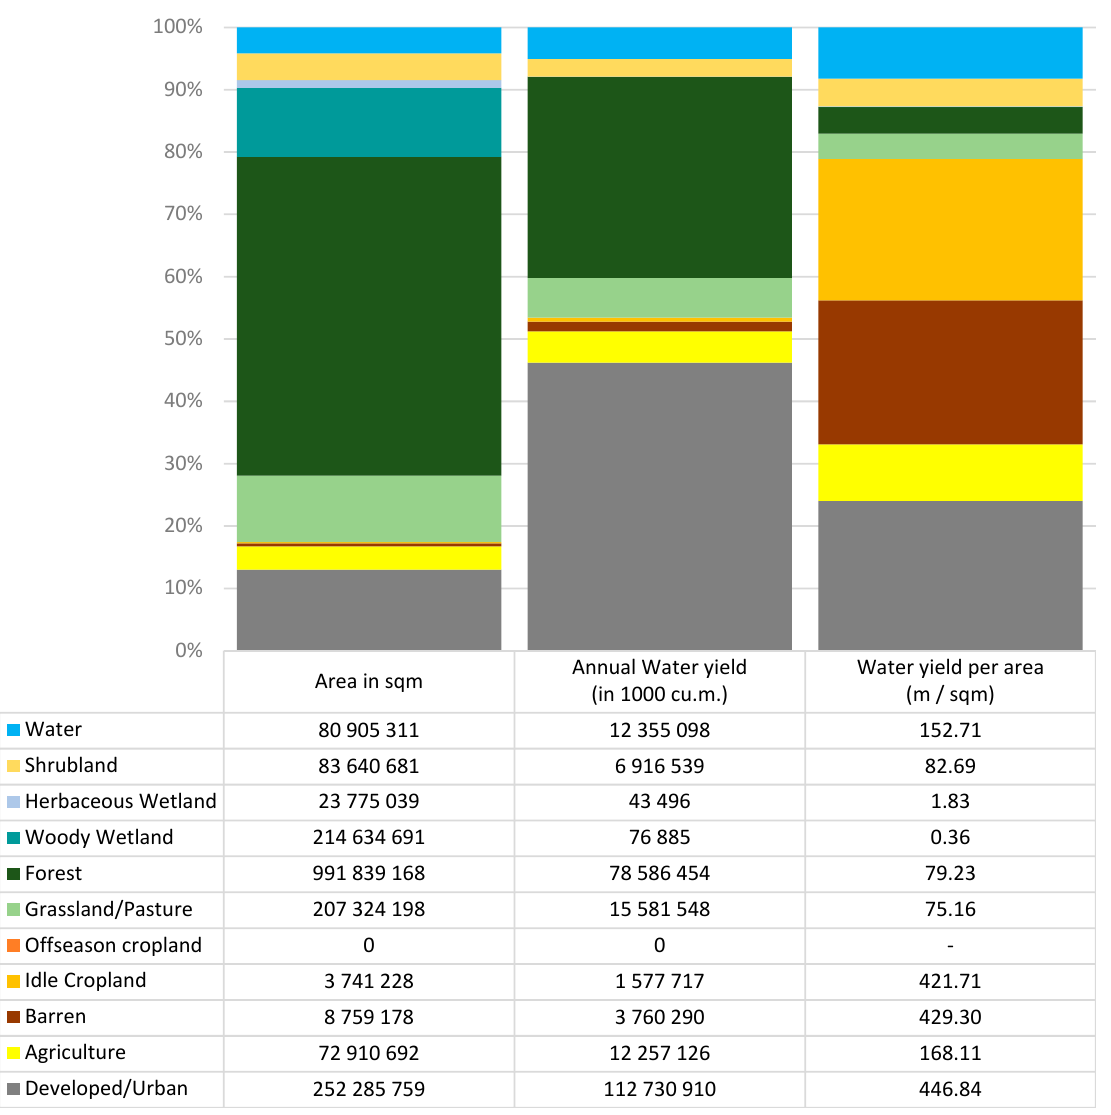
Figure 9. The urban/developed land cover has the highest annual total water yield potential, while the non-vegetated areas (i.e., developed/urban, barren, idle cropland) recorded the highest mean water yield potential per area.